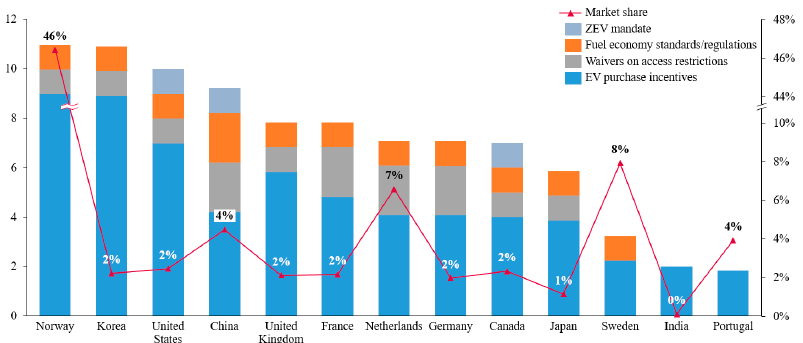
Figure 2. EV market share and policy incentives in 2018.